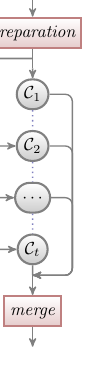
Figure 1: Illustration for vertical